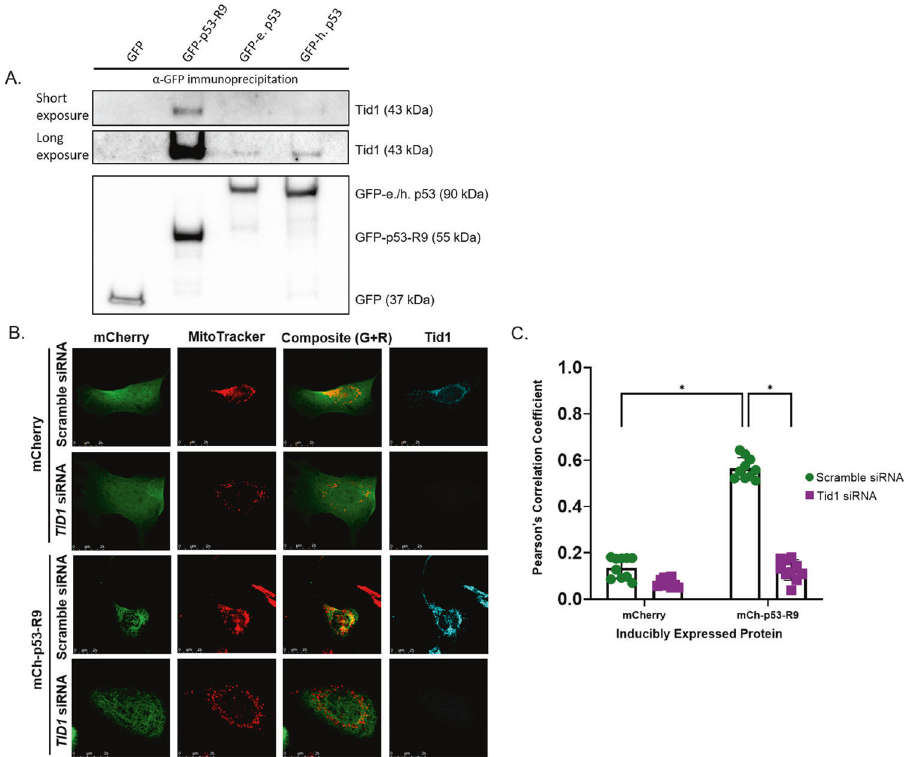
Fig. 6 p53-R9 binds translocation chaperone Tid1, and p53-R9 localization at the mitochondria requires Tid1 expression. A U2OS TP53 − / − cells were transfected to express GFP, GFP-p53-R9, GFP-e. p53, or GFP-h. p53. Cells (10 6 ) were lysed 8 h after transfection, then immunoprecipitation was performed with GFP-Trap beads. Immunoprecipitates were analyzed for Tid1 and GFP expression via immunoblot. B Representative confocal images of cells expressing mCherry or mCherry-p53-R9 and labelled with mCherry antibody (Green), MitoTracker (Red), and Tid1 antibody (Cyan) show the localization of the inducible protein (mCherry or mCh-p53-R9) in the presence or absence of transport chaperone protein Tid1 after transfection with scramble or Tid1 siRNA. Composite image includes both the green and red channels to show colocalization. Tid1 knockdown results in a punctate pattern in the MitoTracker signal, as previously published (Ng A, 2014). C Colocalization of mCherry antibody and MitoTracker signals determined by Pearson ’ s Correlation Coef fi cient after Otsu auto threshold applied to remove background. N = 100 cells from ten separate images visually positive for both mCherry and MitoTracker signal prior to background removal. There is signi fi cantly more correlation between the mCherry signal and the MitoTracker signal in mCh-p53-R9 (Scramble siRNA) vs both mCherry (Scramble siRNA) and mCh-p53-R9 (Tid1 KD); Two-Way ANOVA with Tukey ’ s multiple comparison test and correction * p < 0.0001. Error bars represent standard deviation of ten images collected across three experimental replicates (3 or 4